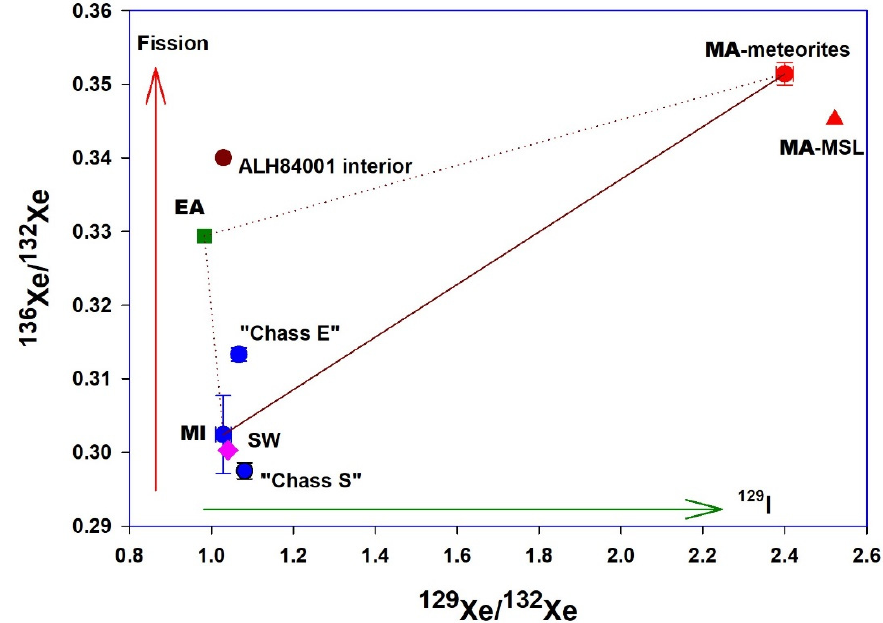
Figure 8. Xenon three-isotope plot of 136 Xe / 132 Xe vs. 129 Xe / 132 Xe showing di ff erent Martian Xe components. The solid line represents the mixing line between Mars atmosphere and interior, while the dotted line represents terrestrial contamination of Mars atmosphere and interior components. The e ff ects of fission and 129 I decay are also shown. Martian atmosphere and interior components based on meteorite data are from [27–90]. In situ Martian atmosphere is from the work in [41]. In the figure